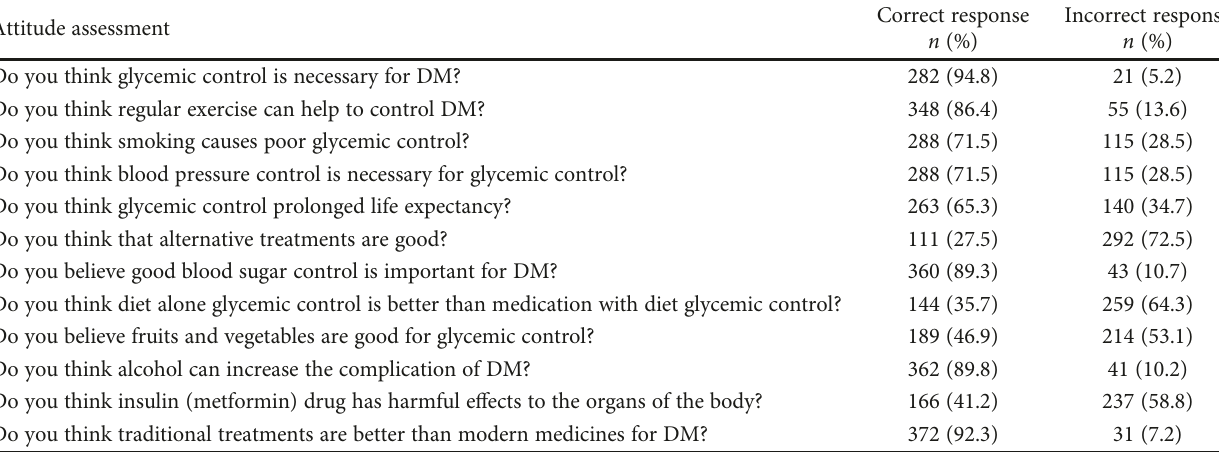
Table 3: Attitude assessment towards glycemic controls among DM patients at the University of Gondar referral hospital 2018. Attitude assessment